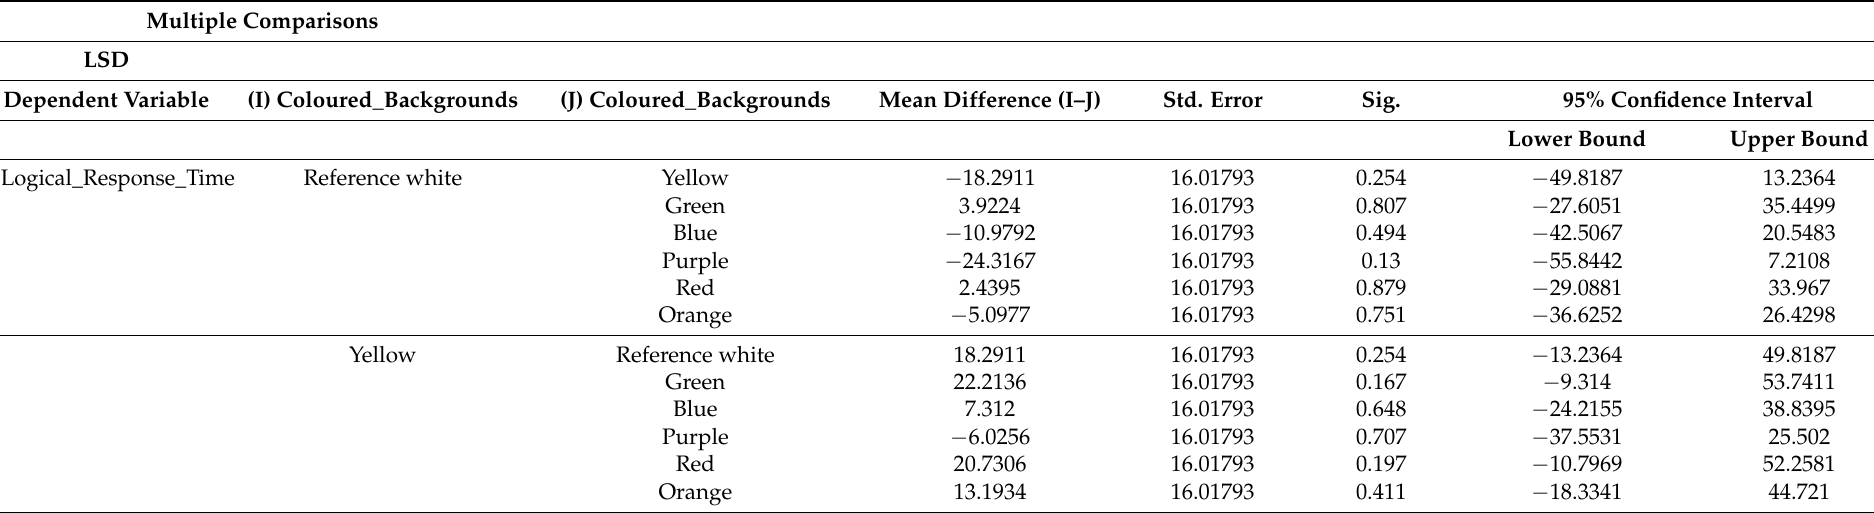
Table A8. Multiple Comparisons of People’s Logical, Lateral, and Detail Abilities Affected by